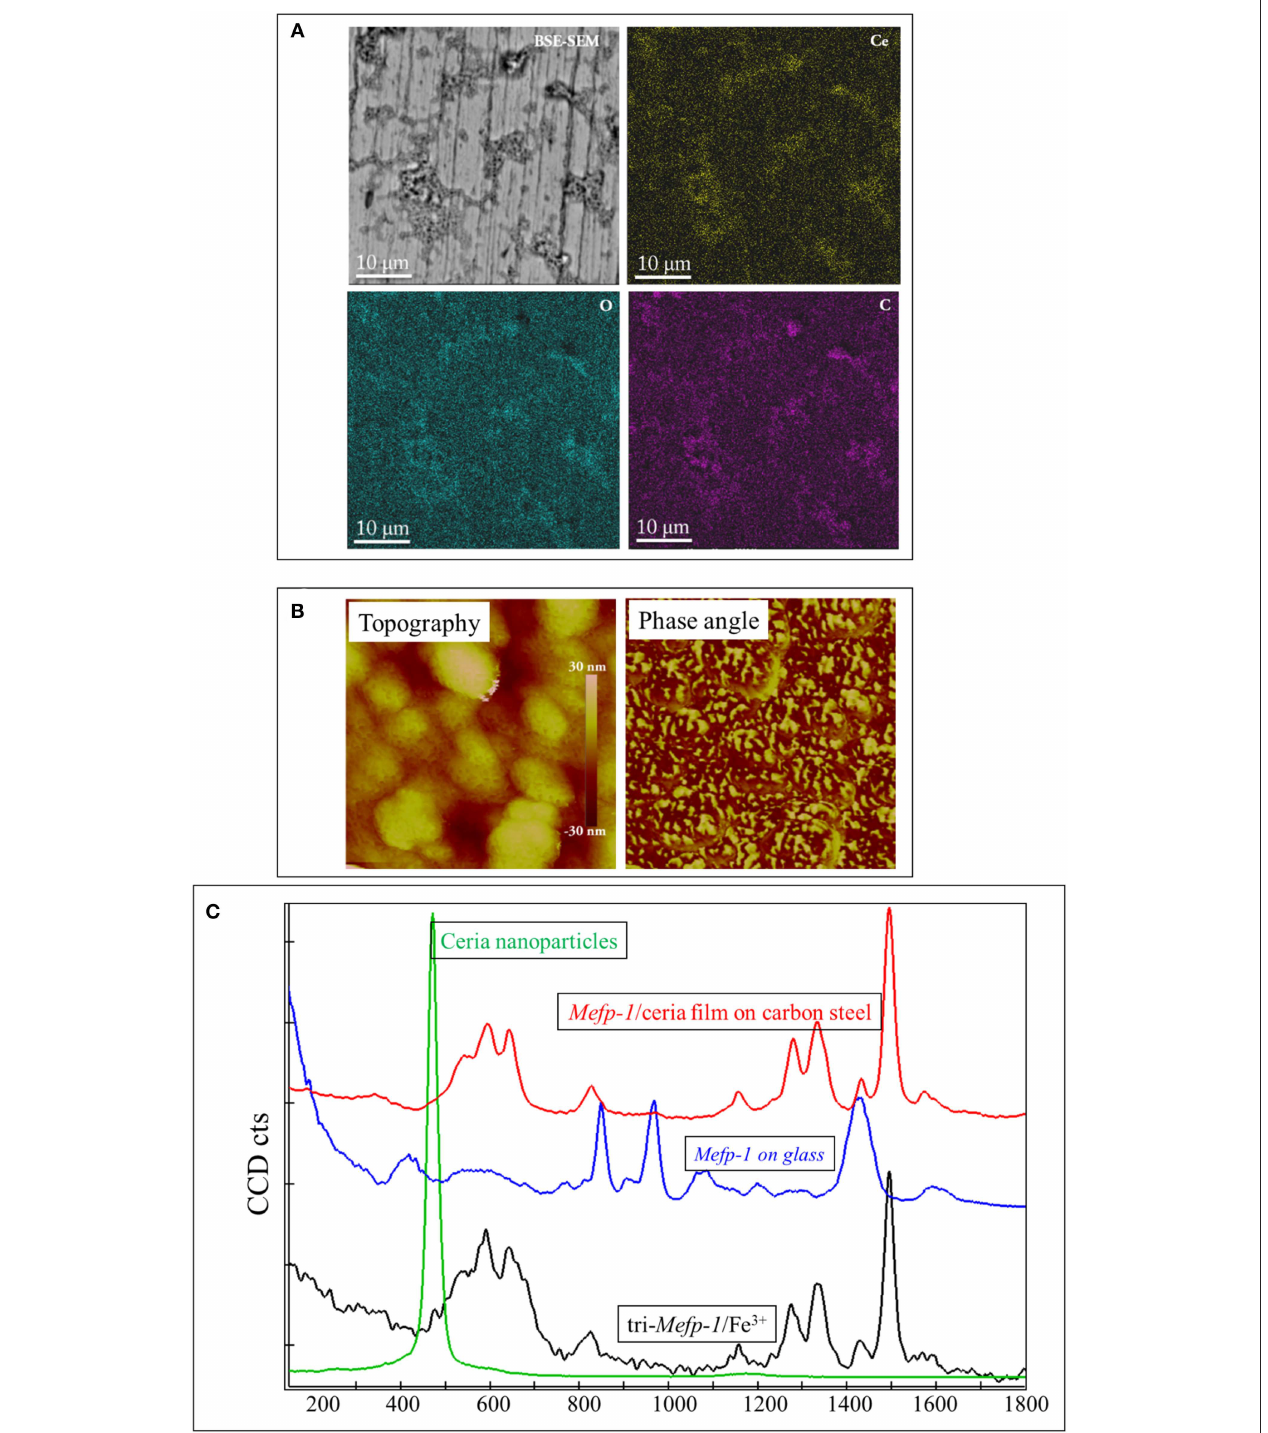
FIGURE 1 | Characterization of the Mefp-1/ceria composite film deposited on the carbon steel. (A) BSE-SEM image and corresponding elemental distribution of Ce, C, and O. (B) AFM topographic image of a compact area (with a size of 500nm) of the composite film, and the corresponding phase image showing two distinct phases. (C) Raman spectrum of the Mefp-1/ceria composite film on the carbon steel, and the reference spectra of the pure Mefp-1 deposited on glass, ceria nanoparticle deposited on glass, and the complex of Mefp-1 with Fe 3 + .